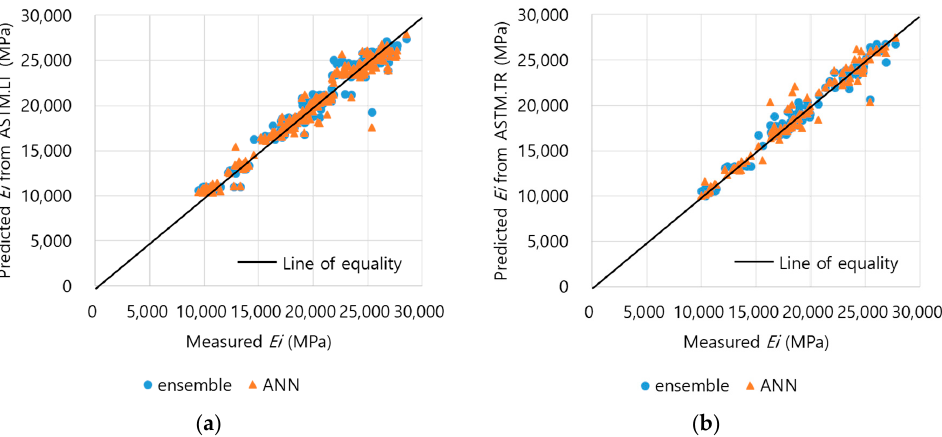
Figure 14. Comparison of Ei predicted with machine learning (ML) and actual Ei. ( a ) Ei predicted by frequency of LT mode, ( b ) Ei predicted by frequency of TR mode.